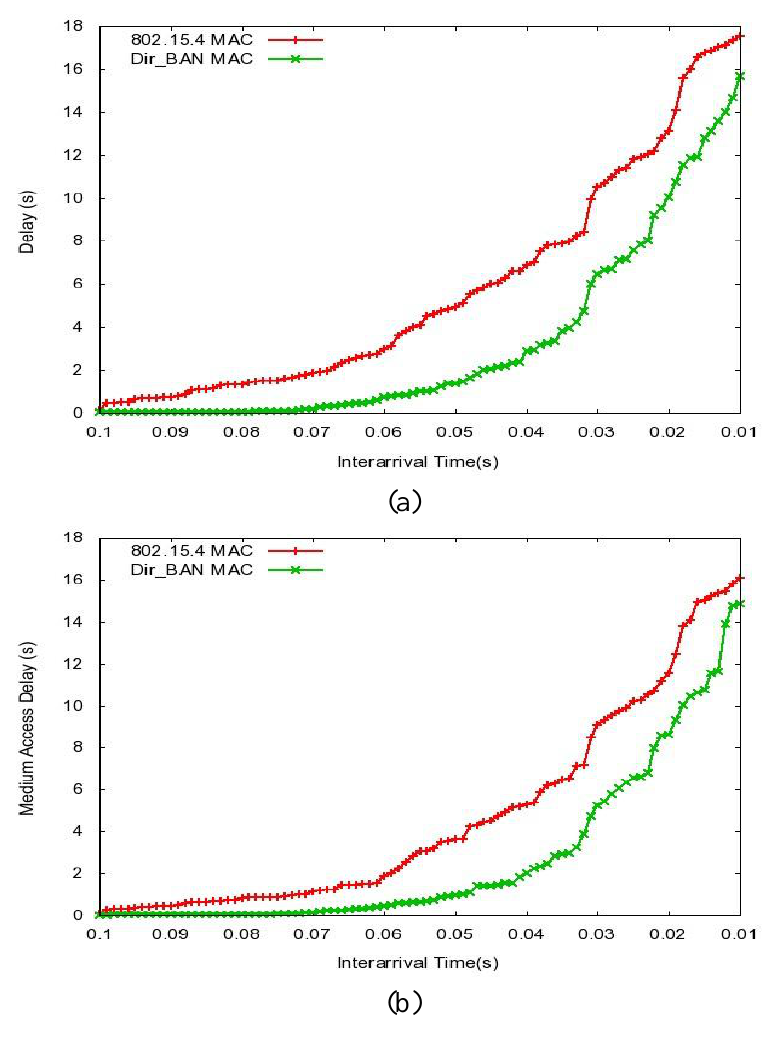
Figure 6. (a) End to End Delay vs. Inter arrival Time. (b) Medium Access Delay vs. Inter arrival Time.